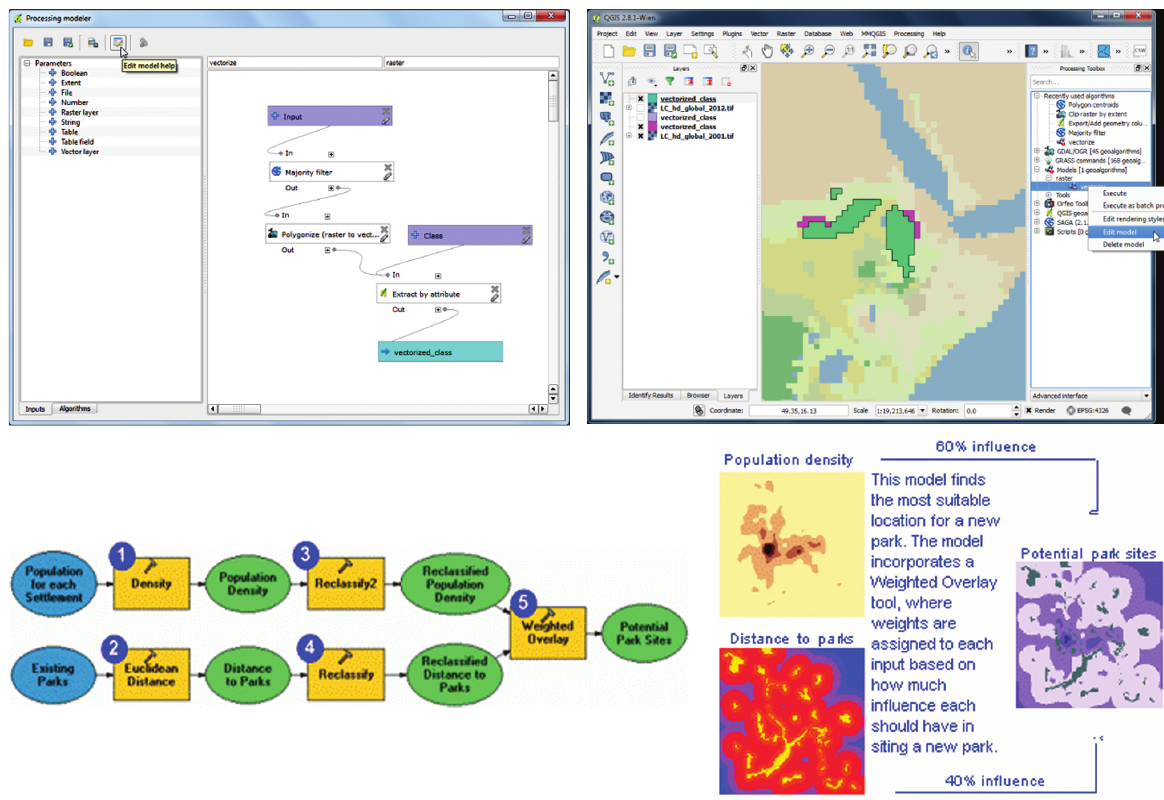
Figure 1. Two examples of geo-spatial data processing workflows from QGIS Processing Modeller 1 (top) and ArcGIS Model Builder 2 (bottom), respectively made for calculating area of water within 25 metres of urban roads (tutorial), and finding suitable locations for urban parks